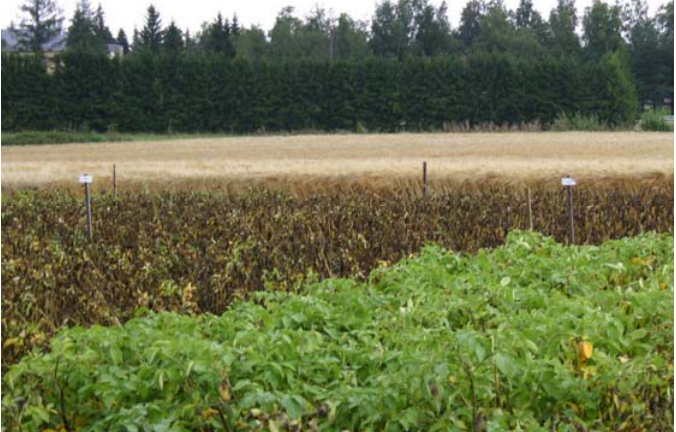
Figure 6. Potato late blight can totally destroy potato crop. Consecutive fungicide applications (green area in the front) are needed for effective control of blight. (Photo: